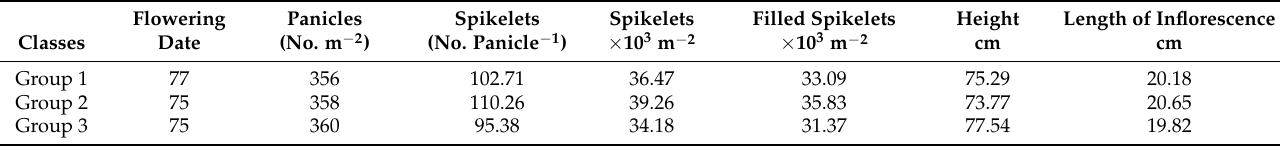
Table 7. Fertility rate, ripened grain, and grain yield of unhulled rice, brown rice (BR), and white rice (WR) of each